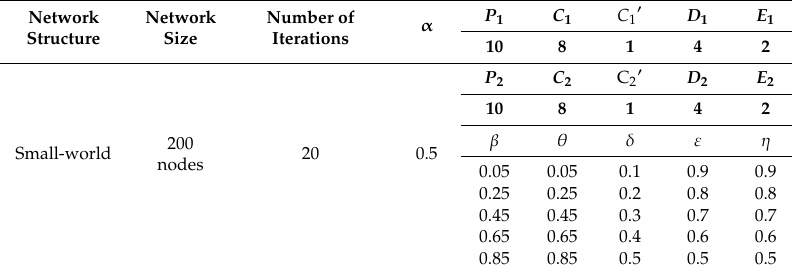
Table 3. Values of Fixed Parameters in the Payment